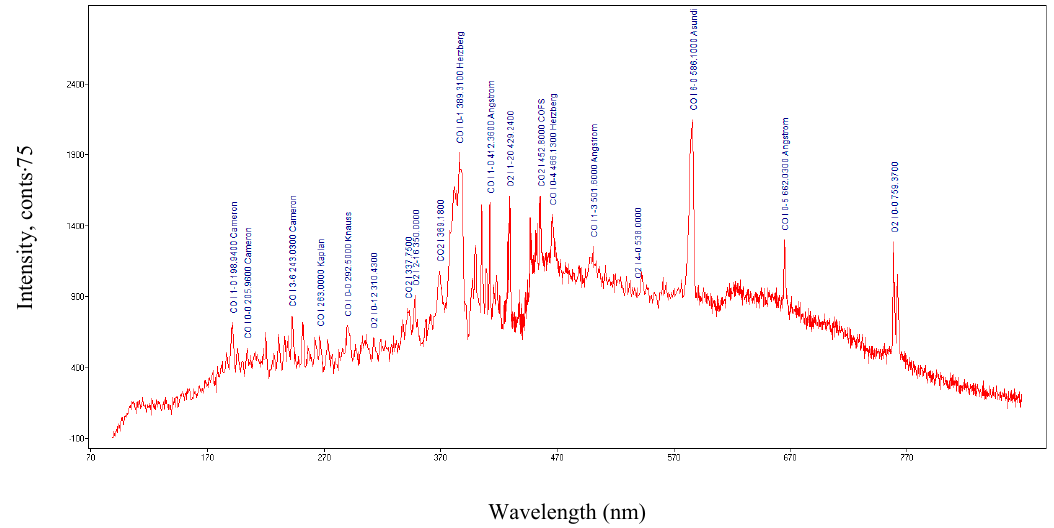
Figure 5. Optical emission spectra of the plasma: The monoxide and oxygen generated during the CO 2 dissociation process.